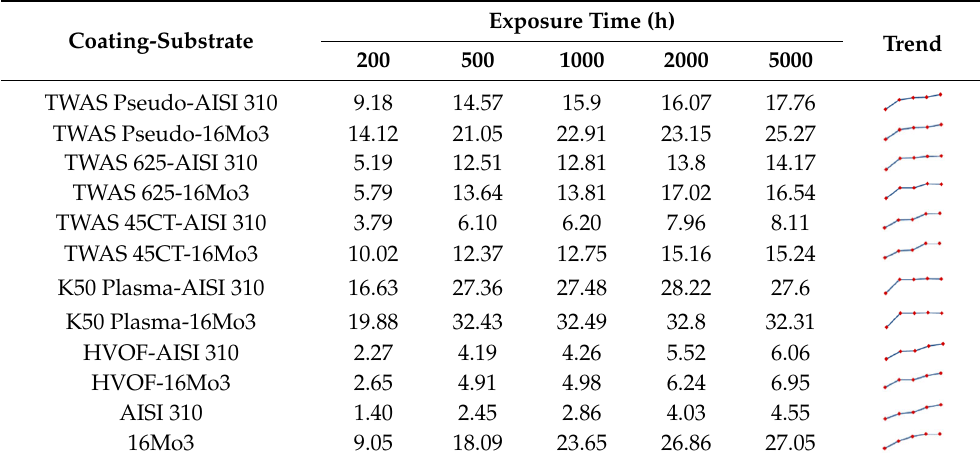
Table 3. Gravimetric results of coatings/materials after exposure at 500 °C in model atmosphere— in g/m 2 .